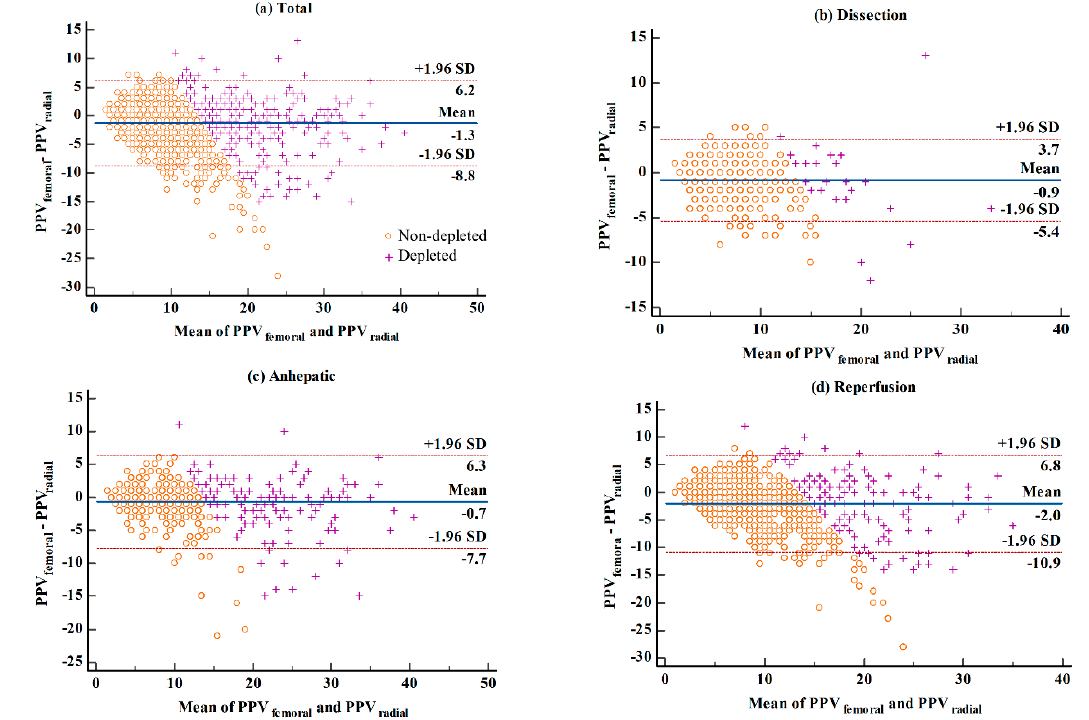
Figure 1. Bland–Altman plot evaluating the agreement of PPV-radial and PPV-femoral during. ( a ) Overall phases, ( b ) the dissection phase, ( c ) the anhepatic phase, and ( d ) the reperfusion phase. Based on value of PPV-femoral, non-depleted values ( ≤ 13%) are presented as orange circle (o), and depleted values (>13%) are presented as purple plus (+).